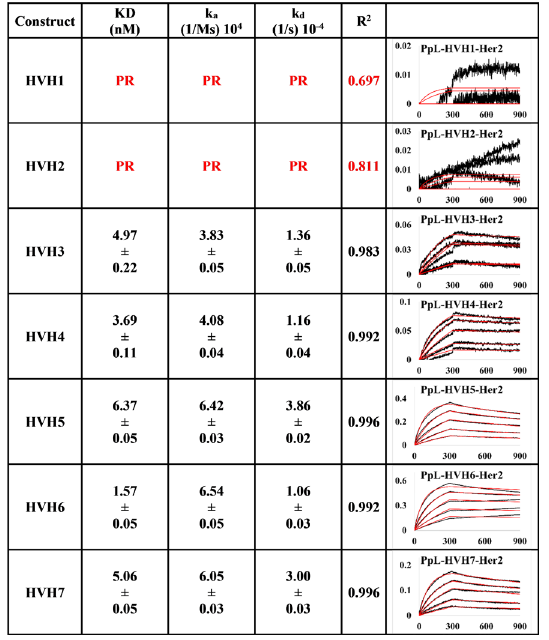
Figure 3. BLI measurement of pertuzumab IgM variants (PVH1-7) interacting with Her2 using Anti-IgM bound on SA biosensor to capture the Fc region of IgM. KD, k , k , and R 2 and fitting curves are shown according to the 1:1 fitting model. The x-axis a d and y-axis of the graph represent the time (s) and response (nM), respectively. All values were rounded off to 2 decimal places. Triplicate experiments were performed, and standard errors are